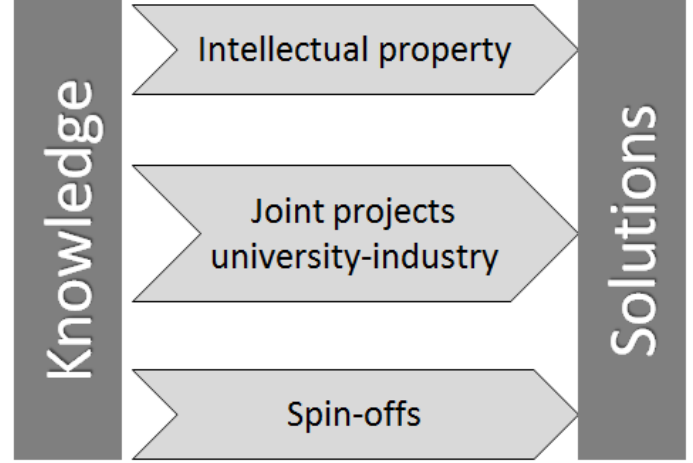
Fig. 1 – The Process of Knowledge